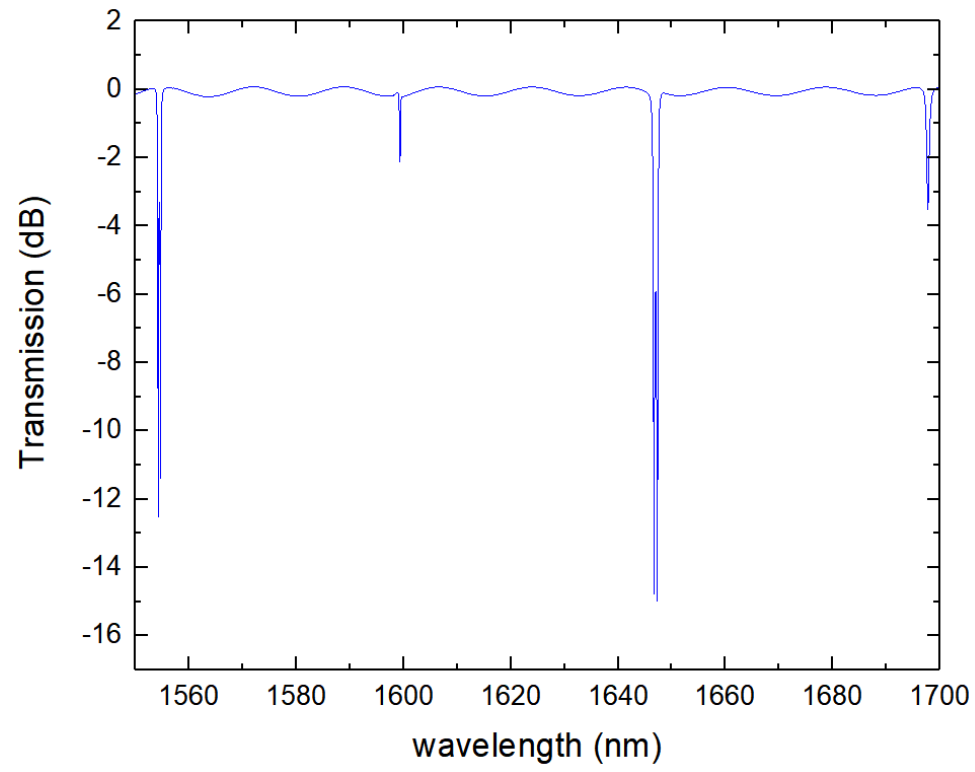
Figure 11. The output spectrum of grating with periods of 70 and 90 on both sides of the slot.